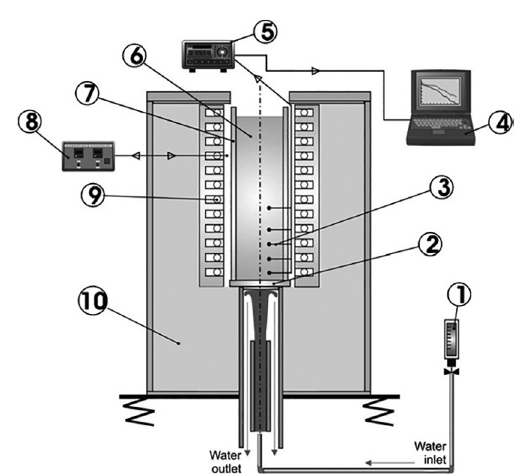
Figure 1. Diagrammatic representation of equipment: (1) rotameter; (2) thin steel plate; (3) thermocouples; (4) temperature acquirement software and computer; (5) data logger; (6) melt; (7) steel mold; (8) temperature controller; (9) electric heaters; (10) insulating ceramic shielding.